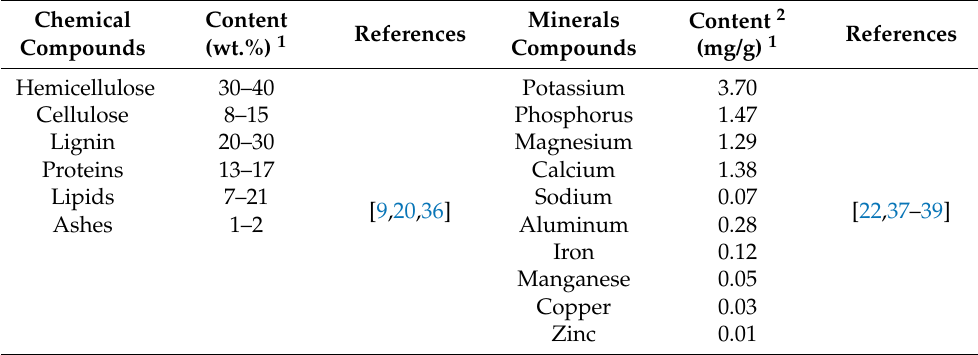
Table 1. Chemical compounds and minerals compounds found in